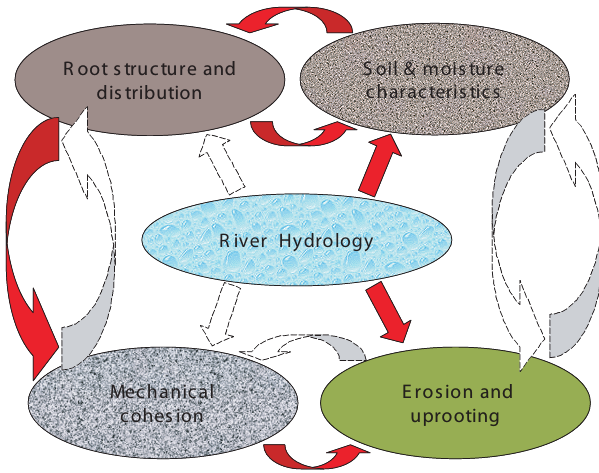
Fig. 1. Processes and interactions involved in root anchoring of pioneer alluvial vegetation in non textured e.g. alluvial soil.